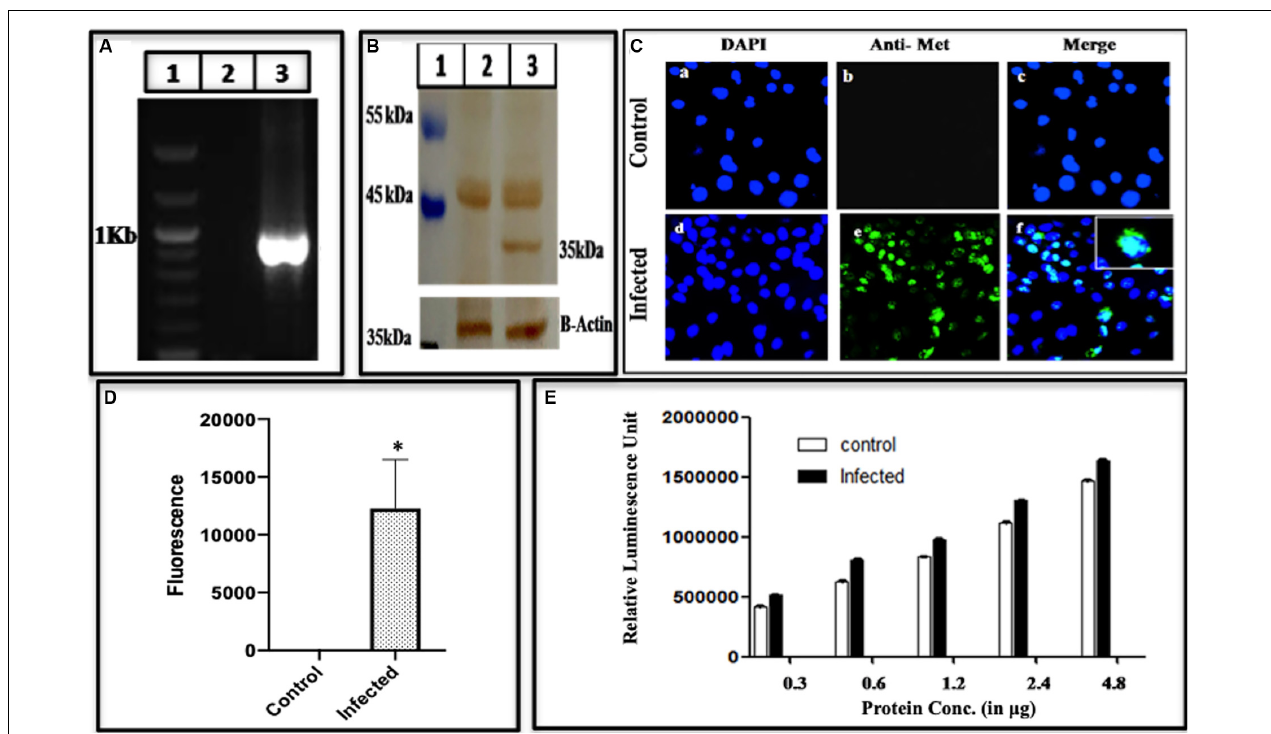
FIGURE 4 | Expression of active methyltransferase. (A) PCR Amplification of methyltransferase from BacMam-HEV infected cells using primers G3MeTF and G3MeTR ( Supplementary Table S1 ). The corresponding lanes are as follows: Marker (lane 1), cDNA from uninfected cells (lane 2), cDNA from infected cells (lane 3). (B) Western blot analysis using anti-methyltransferase antibody and Goat Anti-Rabbit IgG HRP conjugated secondary antibody. The corresponding lanes are as follows: Marker (lane 1), cell lysate from Huh 7 control cells (lane 2), cell lysate from infected Huh 7 cells showing specific band identical to the size of methyltransferase (lane 3). (C) Immunofluorescence assay: cells were stained with Anti-MeT detected with Alexa Fluor 488 Goat Anti-Rabbit IgG secondary antibody and counterstained with DAPI to stain nuclei. Panels (a–c) represent control Huh7 cells, and panels (d–f) represent HEV infected cells. Panels (c,f) represent the merged image. The Immunofluorescence was performed three times as independent experiments. (D) The graph represents the mean fluorescence intensity, and the error bar indicates the standard deviation. Statistical significance of data was determined by the Mann–Whitney test ( p -value = 0.0286). * indicates p -value < 0.05. (E) Methyltransferase activity using MTase-Glo reagent. The histogram shows an increase in methyltransferase activity upon an increase in enzyme concentration. The activity was performed three times in triplicates and the bar indicates the standard deviation. The statistical significance of data was tested